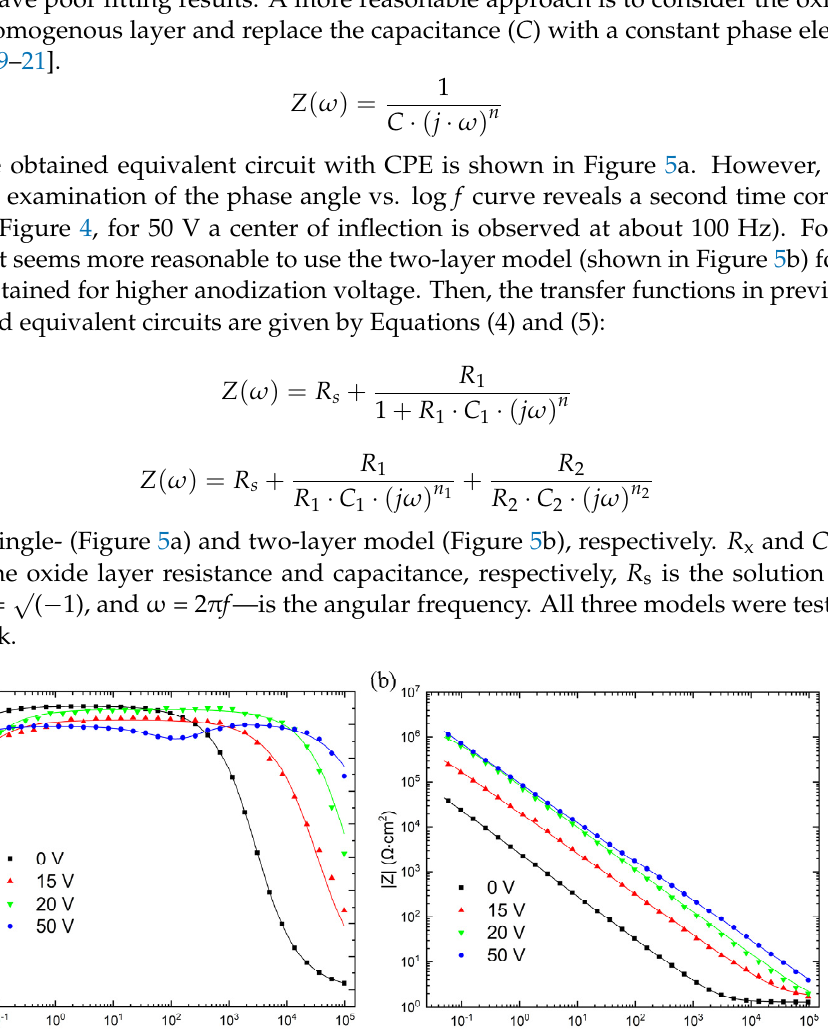
Figure 5. Used equivalent circuits for EIS measurements ( a ) single layer, ( b ) double layer. The alternative estimate of the oxide film capacity based on EIS was performed in this work with the use of a single frequency. It seems to underestimate obtained values as compared to measurements using the entire EIS spectrum. This tendency may be due to the inhomogeneity of the obtained oxide film. The obtained value of the n parameter had a mean value of about 0.95 and less. After all, this method gives a linear dependence of reciprocal capacity on forming voltage (see Figure 6). The obtained reciprocal capacity was slightly smaller than that obtained under similar conditions by Young [4].